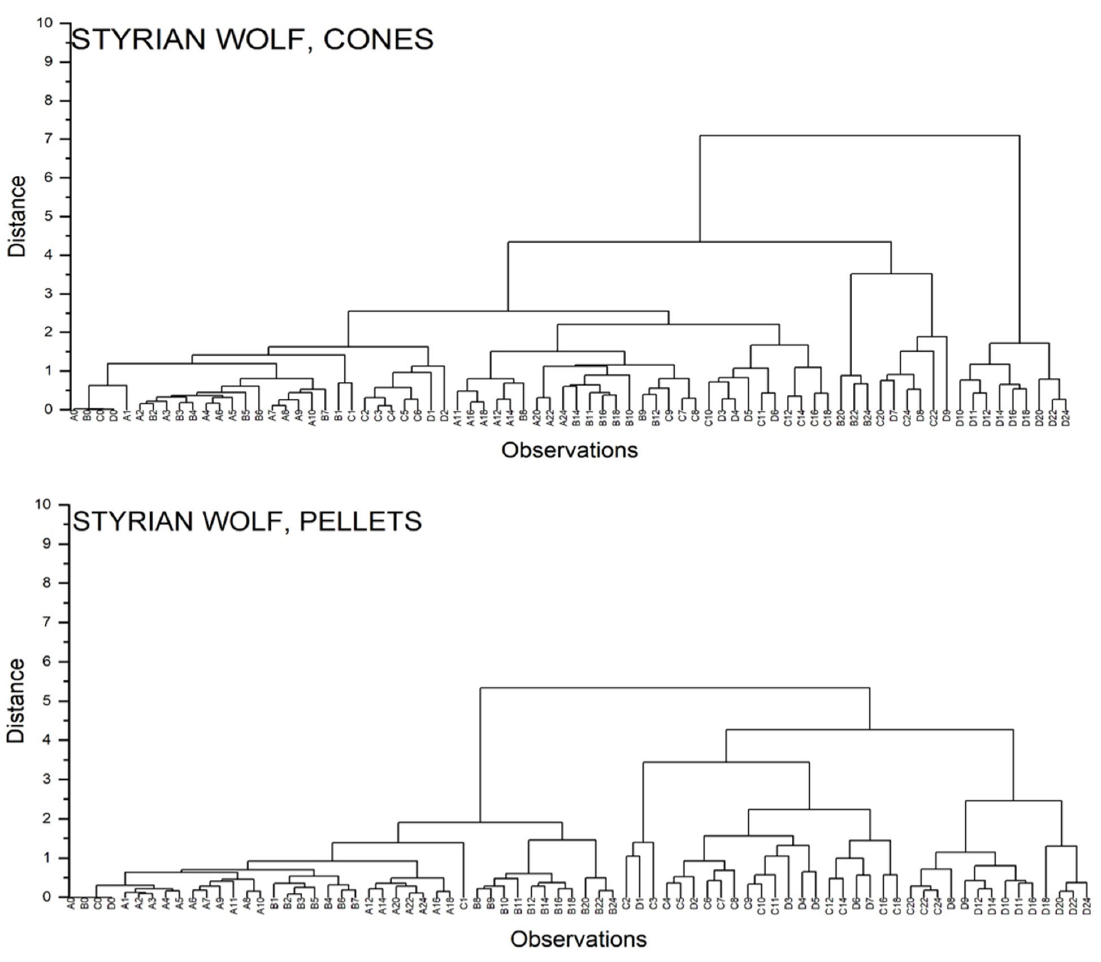
Figure 10. Dendrograms for Styrian Wolf cones and pellets.